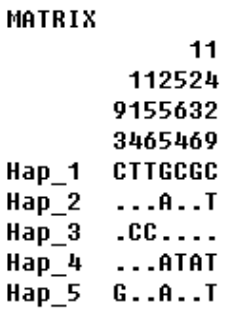
Figure 1. Variable sites in cytochrome oxidase I gene of haplotype in generations 0, 5, 10, 15, 16, 17 of Langshan conservation population. -, indicate the same base.